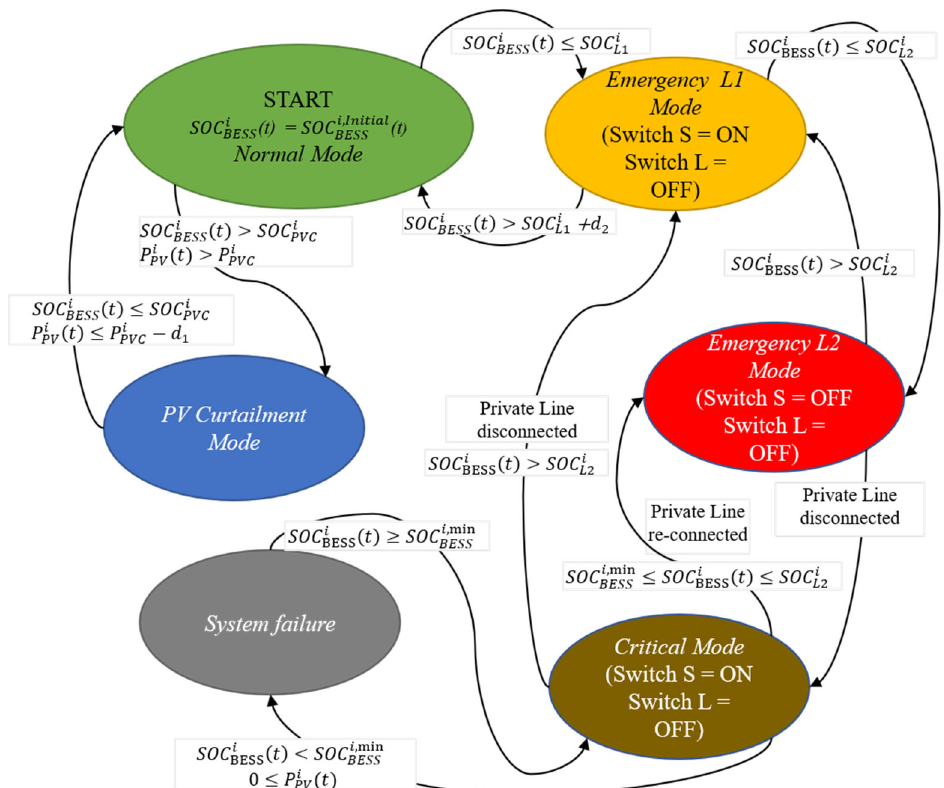
Figure 6. The proposed EMS simulator flow.